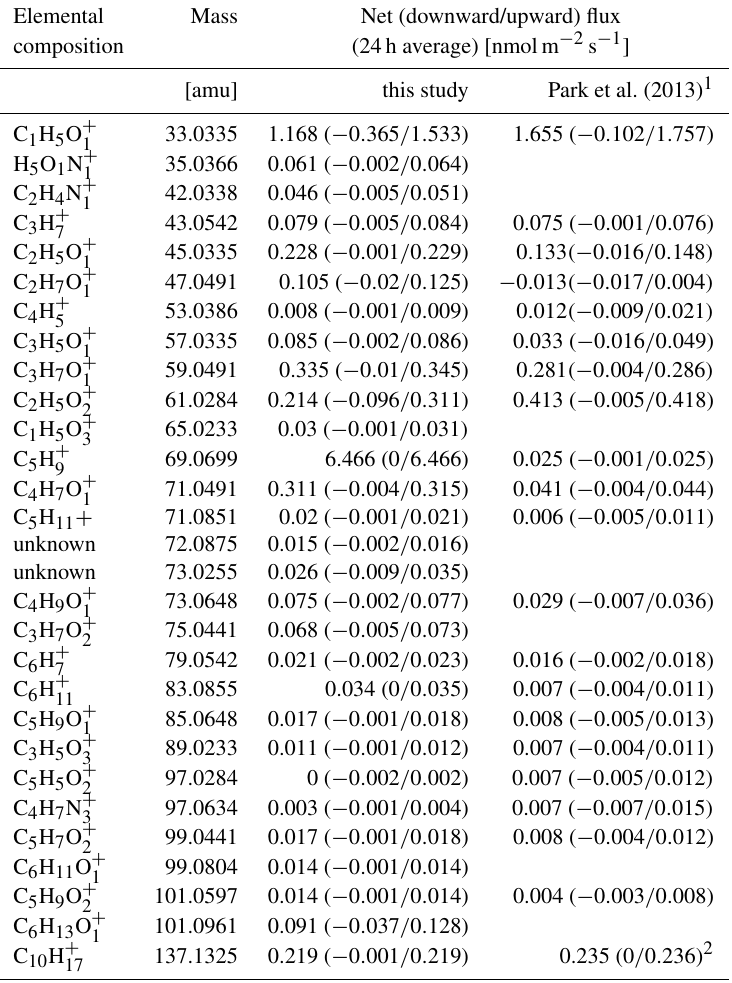
Table A2. Comparison of the detected compounds with flux in Bosco Fontana and their values at the orange grove (Park et al., 2013). Elemental Mass Net (downward/upward) flux composition (24h average) [nmolm − 2 s − 1 ] [amu] this